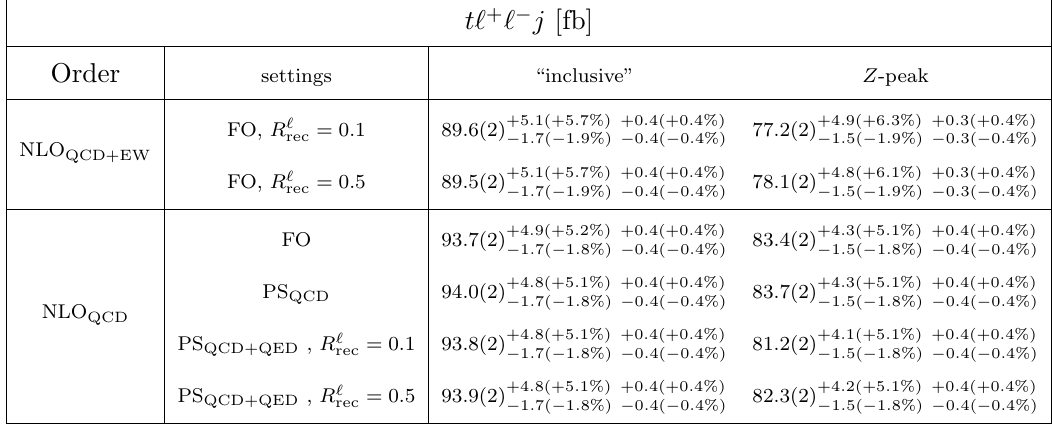
Table 3 . Cross section comparisons for t‘ + ‘ (cid:0) j